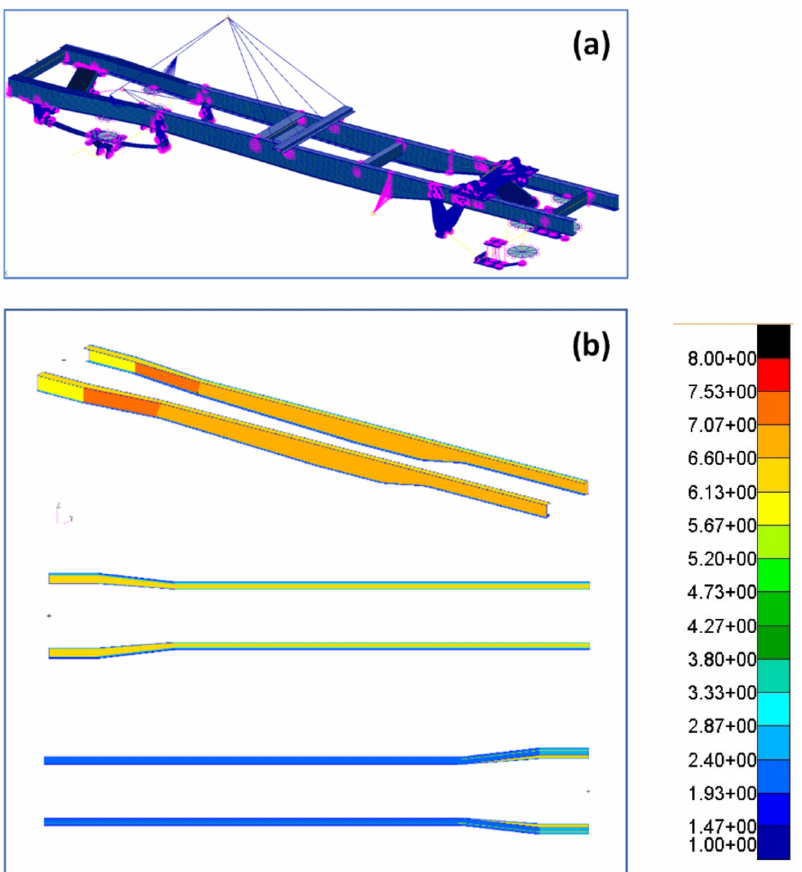
Figure 17. ( a ) Optimized design (mass of chassis without suspensions and point masses = 275 kg) ( b ) thickness distribution of the side